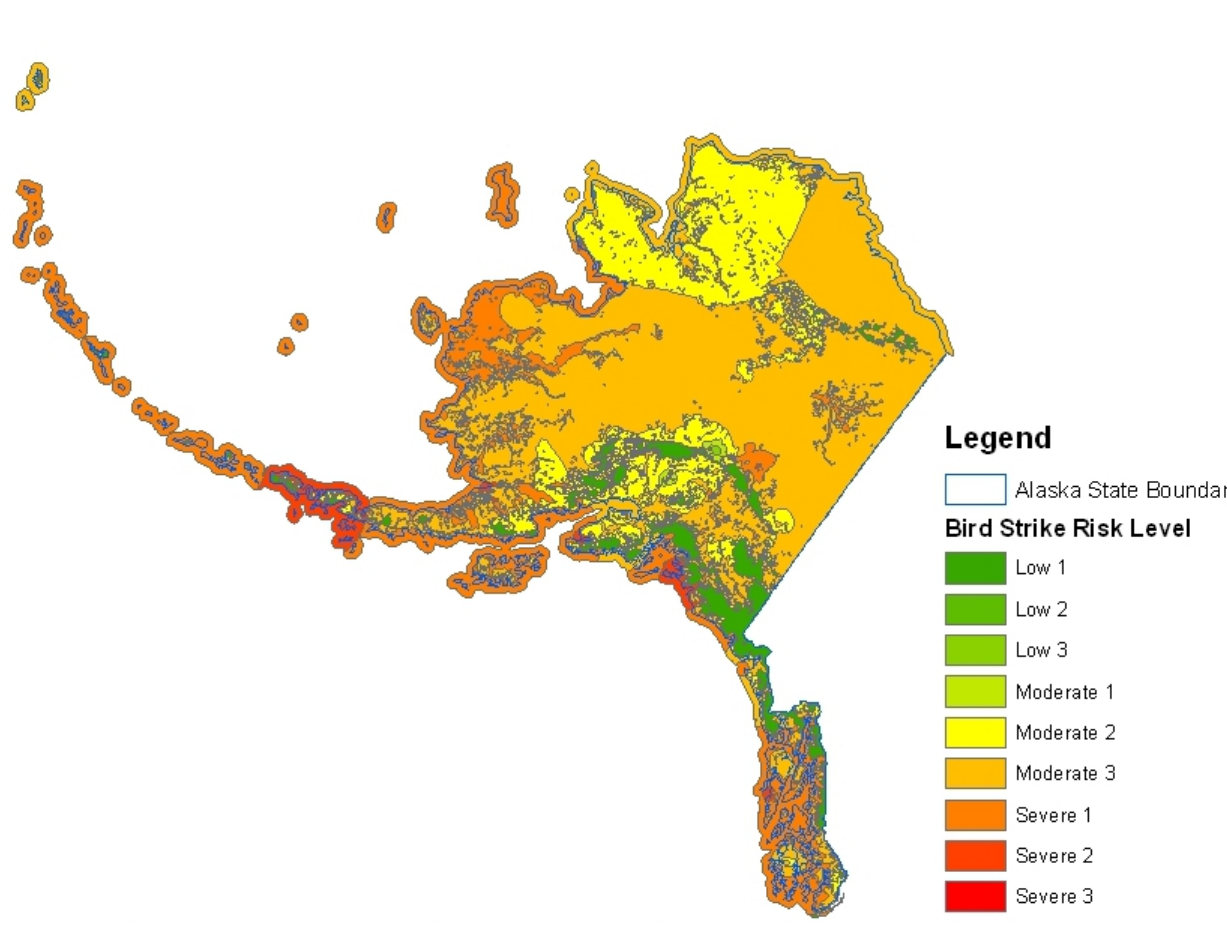
Fig. 4. A sample bird strike risk map for Alaska from the United States bird avoidance model during the period 7–20 May, during